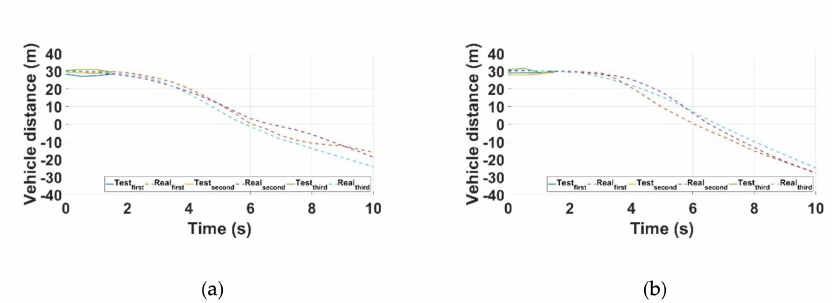
Figure 19. Comparison of theoretical values and real vehicle test results based on distance to the lead vehicle: ( a ) scenario 11 and ( b ) scenario